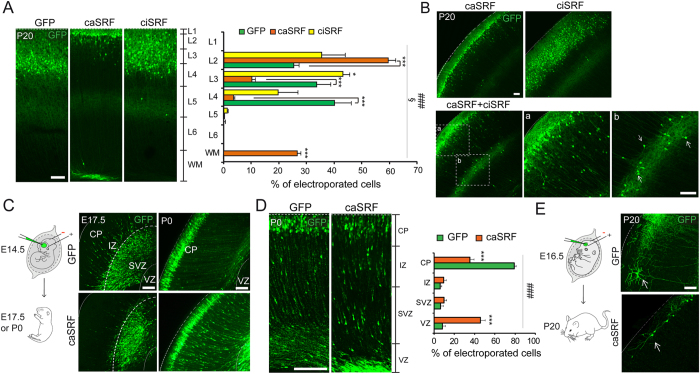
Enhanced SRF activity slows down migration and impairs cortical lamination.(A)Quantification of the relative position of the somas of electroporated neurons at P20 in GFP, caSRF and ciSRF conditions revealed the impaired positioning in the cortical layers. The left panels show representative images of electroporated cortices. L1-L6: layer 1- layer 6, WM: white matter (B) Partial rescue of caSRF-induced changes in cortical development by co-electroporation with ciSRF. (a) Detail showing the modest impact of ciSRF co-expression in the lamination defect caused by caSRF. (b) The white arrows label multipolar cells-like neurons that were probably halt in the migration process. (C) Scheme of the experiment and representative images of coronal brain sections of E17.5 and P0 cortices electroporated at E14.5 with caSRF or GFP. CP: cortical plate, VZ: ventricular zone, IZ: intermediate zone, SVZ: subventricular zone. (D) Higher magnification images of P0 cortices. The right bar graph shows the quantification of the relative position of electroporated neurons at P0, showing the delayed migration and accumulation in the VZ of caSRF-expressing neurons. (E) Scheme of the experiment and representative images of coronal brain sections (P20) showing the morphology of electroporated neurons located in layer 2 (white arrows). Scale bars: 100 μm. Note that data in bar graphs are expressed as means of the percentage of GFP+ cells ± SEM and were compared using 2-way ANOVA for repeated measure, followed by the Bonferroni’s multiple comparison test. The (*) symbols indicate statistical difference between caSRF or ciSRF and GFP control conditions; (#) and (§) symbols indicate statistical interaction between the electroporated construct and layer distribution for caSRF and ciSRF, respectively. *p < 0.05; **p < 0.005; ***p < 0.0005; §p < 0.05; ###p < 0.0005 (n = 3).